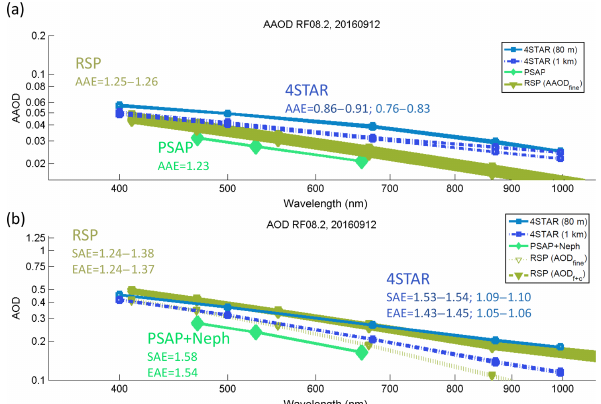
Figure 5. Spectral (a) AAOD and (b) AOD from 4STAR, RSP, and the in situ calculations for the case on 12 September 2016, as well as the AAE, SAE, and EAE values (derived from the slopes in log– log space of AAOD and AOD). RSP EAE and SAE include fine- plus coarse-mode AODs, whereas RSP AAE are for fine mode only. Note that the in situ vertical profile for this case extended from 80m to 5.8km and may have undersampled the coarse-mode sea salt at lower altitudes due to inlet efficiency, whereas the two remote- sensing instruments give full-column values above the P-3 (4STAR) to the top of the atmosphere, or below the ER-2 (RSP), extending to the surface. For the given 4STAR Ångström exponents, the first set refers to the sky scans from 1km, and the second set refers to the scans from 80m, immediately before the aircraft